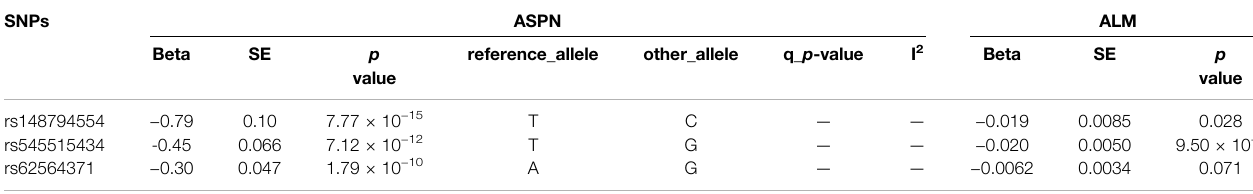
TABLE 2 | Correlation of genetic IVs to ASPN and ALM. SNPs